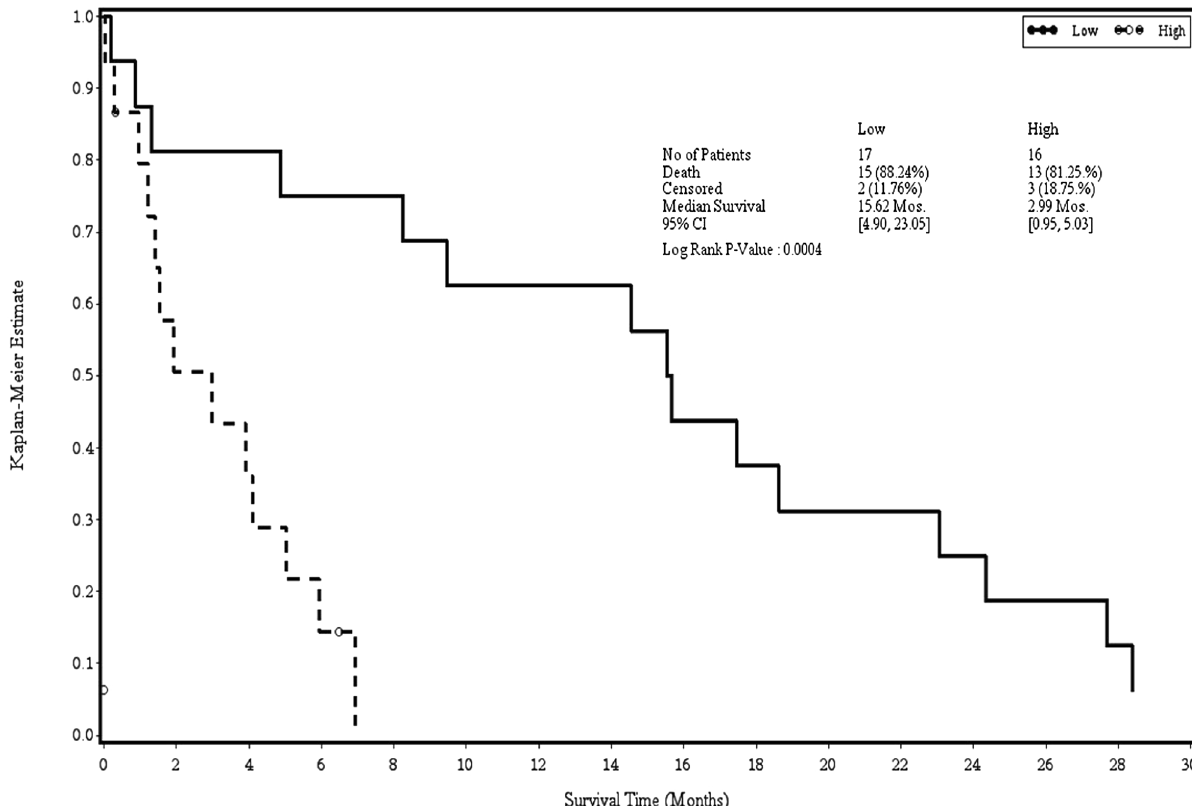
Figure 3. Kaplan–Meier curve for the low-risk and high-risk groups derived from the multivariate Cox